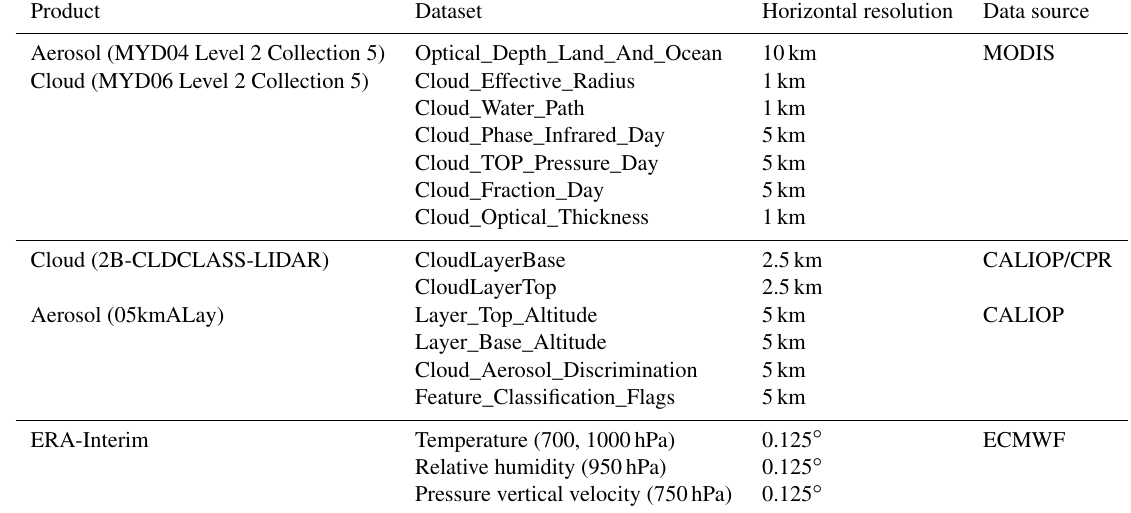
Table 1. Level 2 MODIS, CALIOP, CALIOP/CPR and ERA-Interim products used to characterize aerosol and cloud properties.